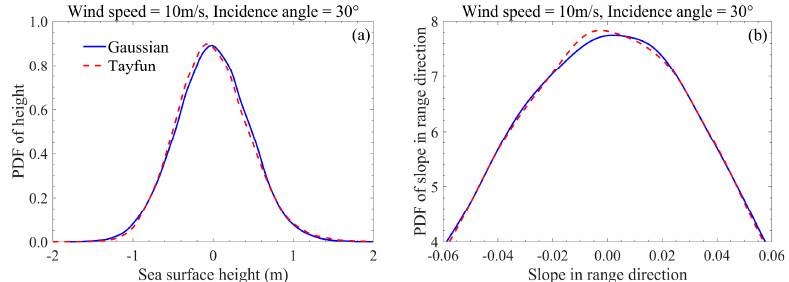
Figure 3. Comparison of distributions of Gaussian sea surface and Tayfun sea surface based on the A spectrum and Cosine spreading function at 10 m/s wind speed and 30° incidence angle along upwind direction. ( a ) Pdfs for surface elevation; ( b ) Pdfs for slope along range direction. Blue solid curve, Gaussian sea surface; red dashed curve, non − Gaussian sea surface constructed by Tayfun model.